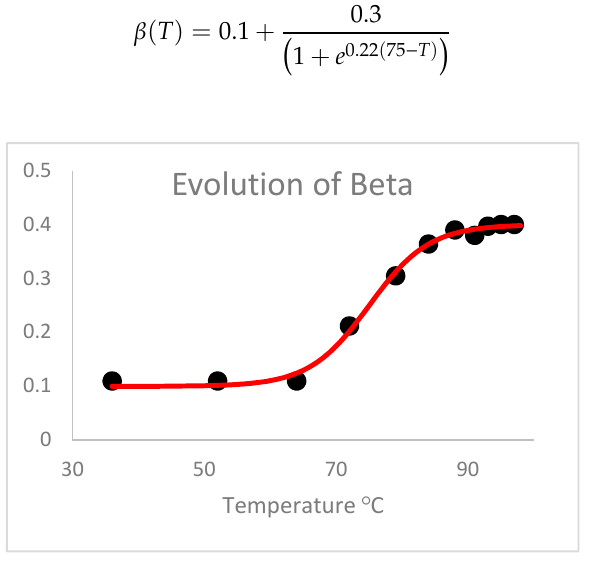
Figure 16. Evolution of 𝛽(𝑇) for EVA